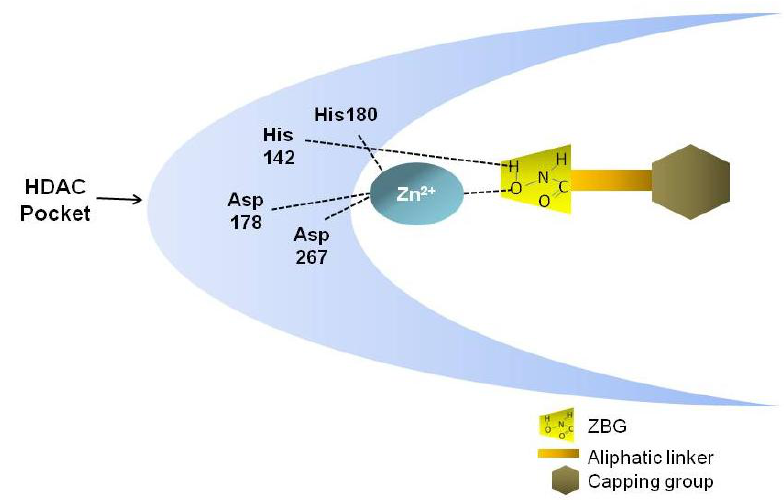
Figure 2. General structure of Hb-HDACI and its interaction with the HDAC enzyme. Hb-HDACIs contain three distinct structural motifs: a zinc binding group represented by the hydroxamic acid, an aliphatic linker that occupies the cavity of the HDAC enzyme, and a surface recognition cap group. The hydroxamic acid interacts with the zinc ion and the histidine 142 in the HDAC pocket inhibiting the enzyme